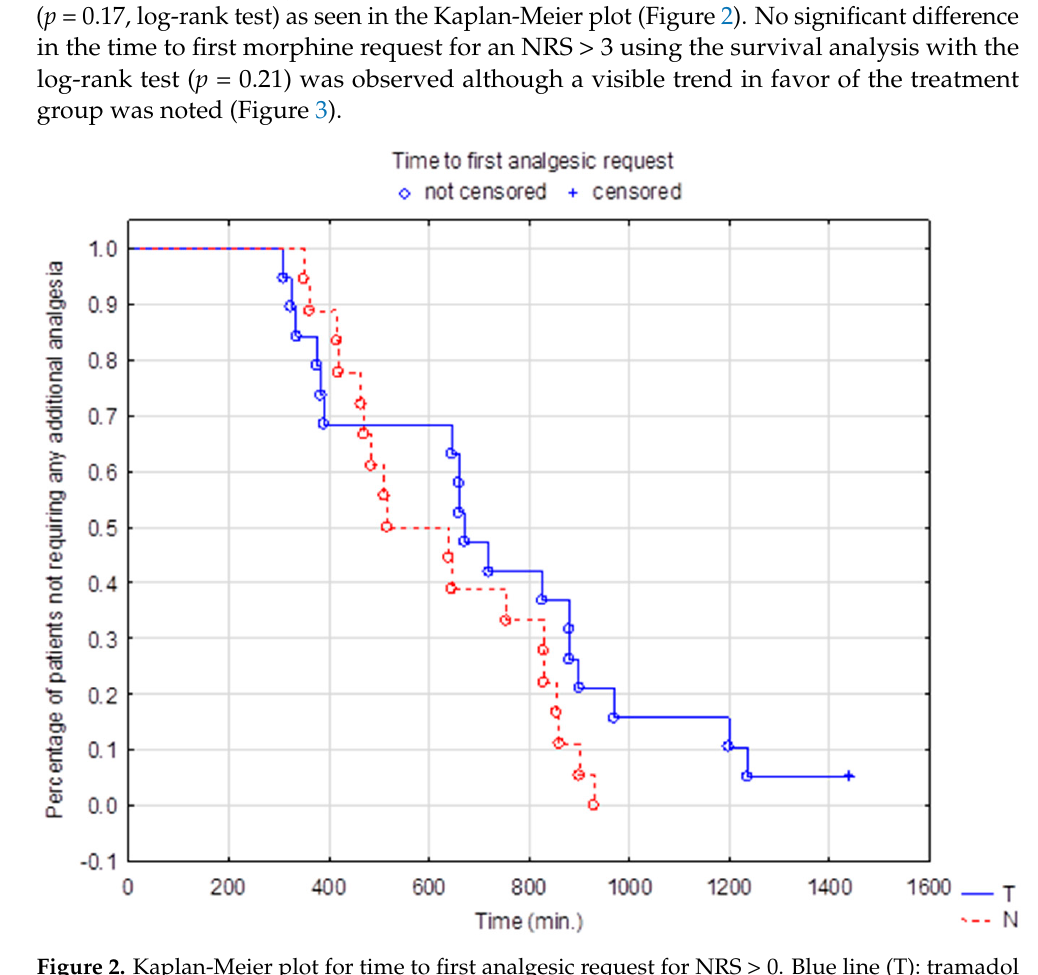
Figure 2. Kaplan-Meier plot for time to first analgesic request for NRS > 0. Blue line (T): tramadol group. Red line (N): control group.